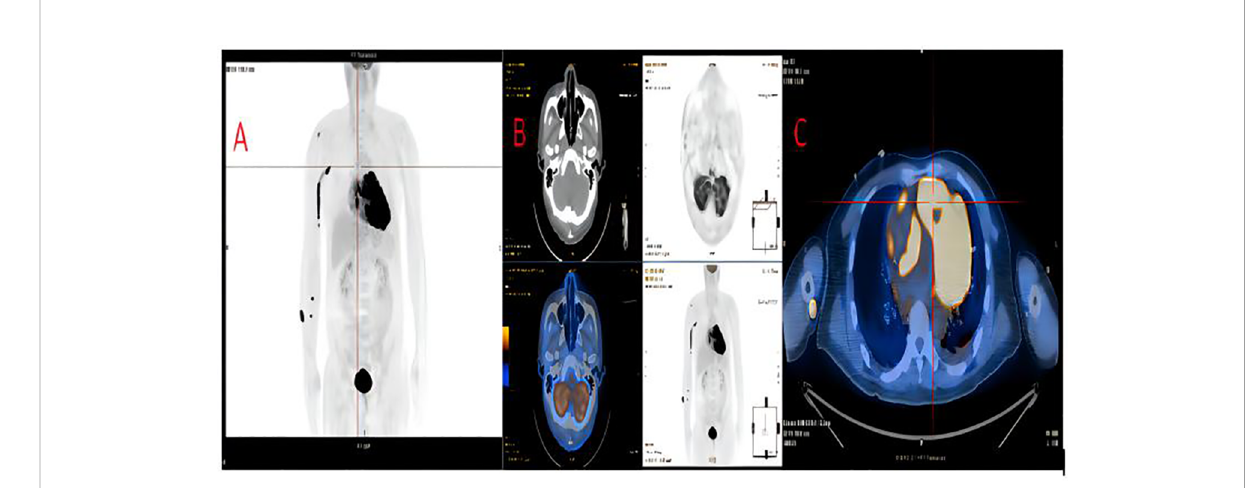
FIGURE 2 The whole pet-ct of this patient. (A) . Multiple involvement throughout the body, including the heart, blood vessels, muscles, and skin. (B) . No involvement of the nasal cavity. (C) . Cardiac involvement: including the LV as well as the funnel of the